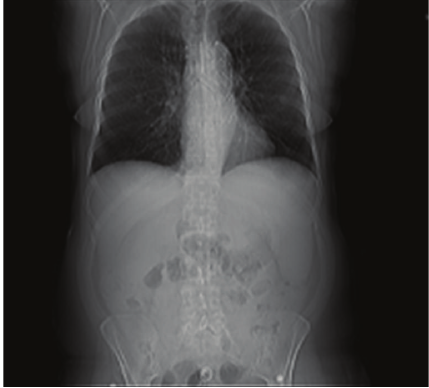
Figure 2: Portable CXR after stent